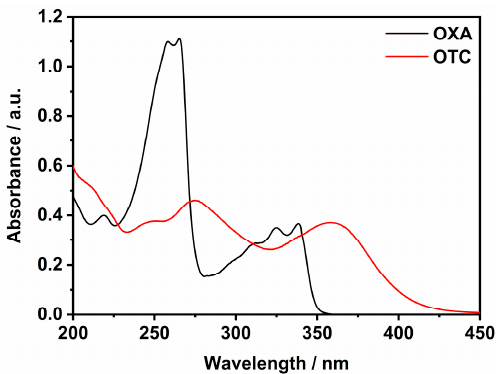
Figure 3. UV / Vis spectra (path length = 1 cm) of water solutions of OXA (30 µ M, pH = 7.0, black curve) and OTC (30 µ M, pH = 7.0, red curve).